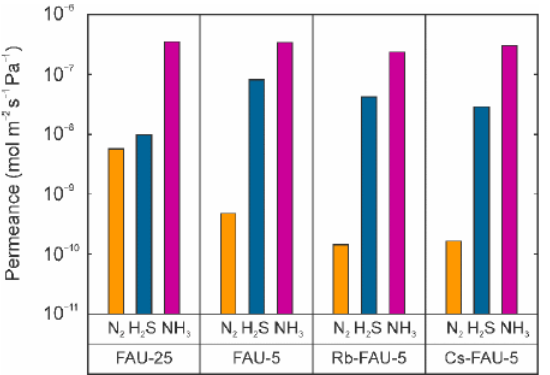
Figure 7. Effect of zeolite composition on gas permeation properties of FAU-type zeolite membranes for ternary mixtures of NH 3 , H 2 S, and N 2 at 295